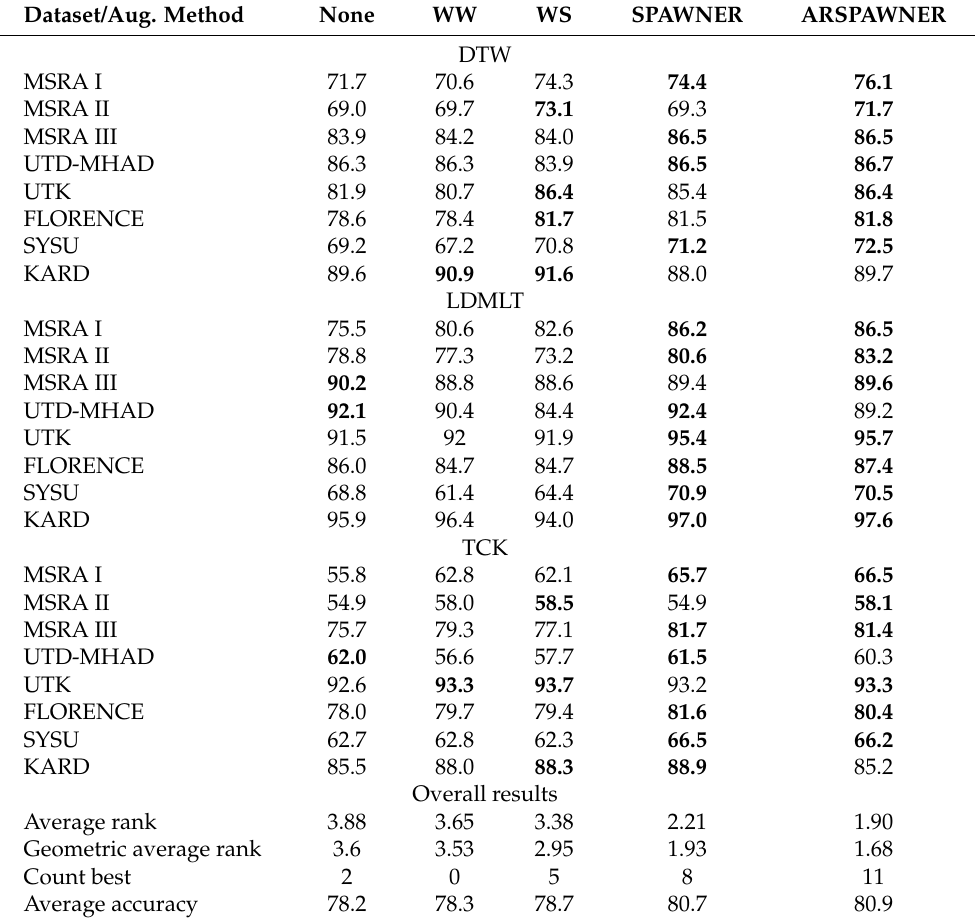
Table 5. Experimental comparison of augmentation methods for three classifiers in terms of classifi- cation accuracy. The two best results for each classifier and dataset are written in bold. Dataset/Aug.